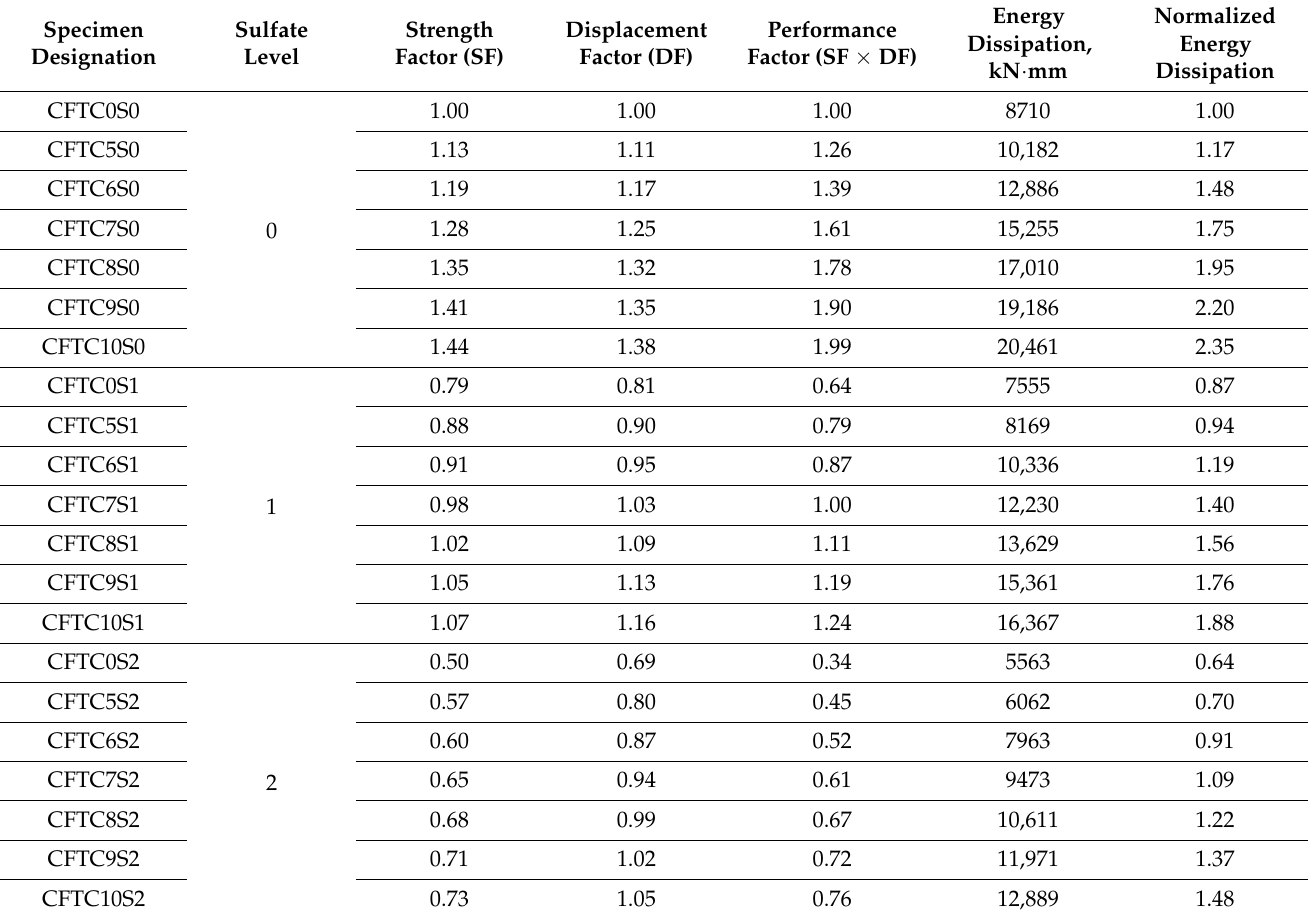
Table 2. Performance improvement factor and energy